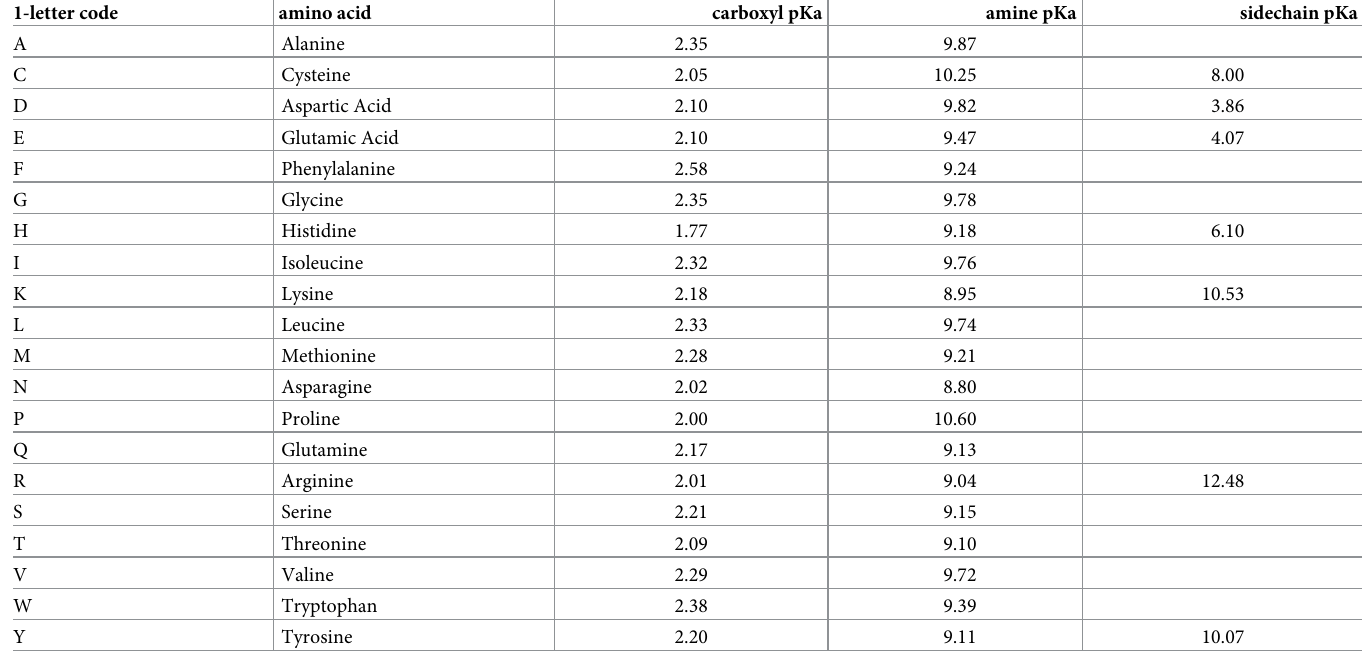
Table 1. The pKa values for the amine groups, carboxyl groups, and side chains that are used in these simulations for the different amino acids